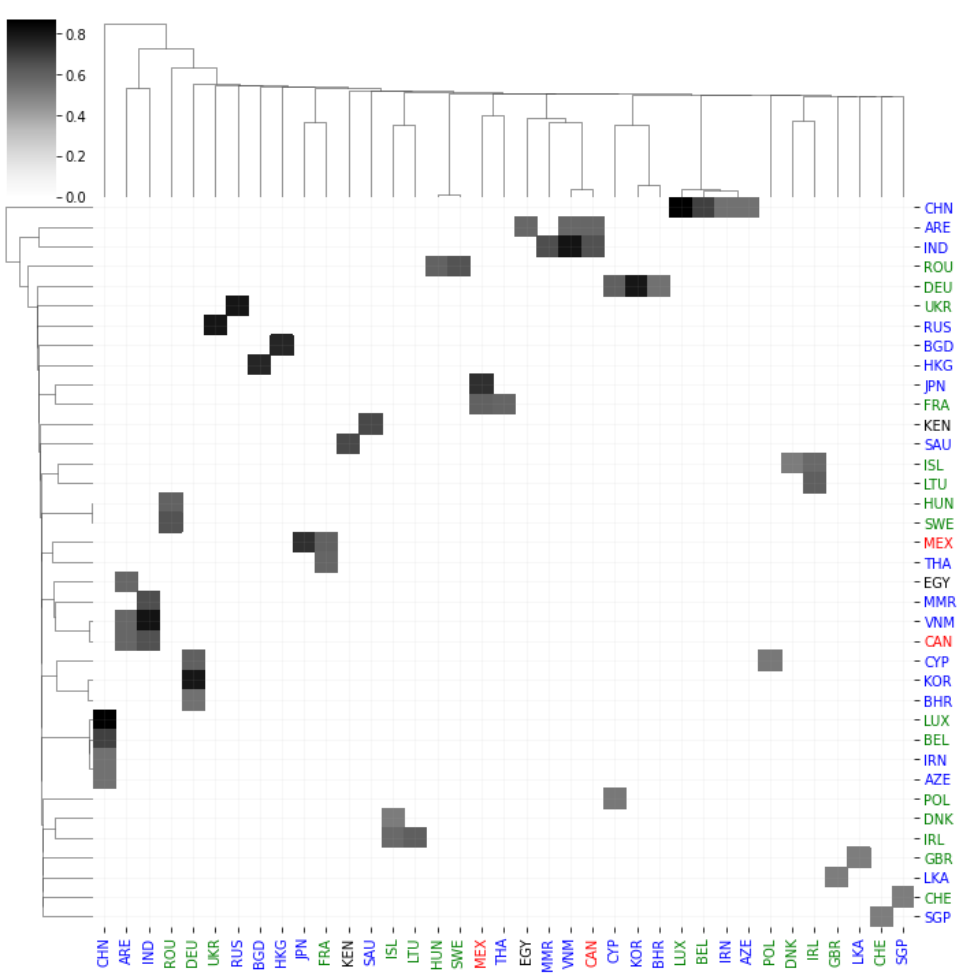
Figure 10. Heatmap of the final travel bubbles obtained in this